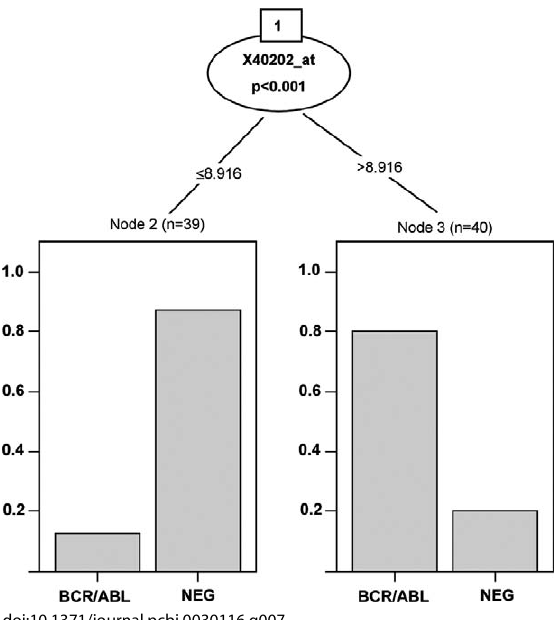
Figure 7. Rendering of a Conditional Tree The figure is obtained with the Ctree function of the party package.